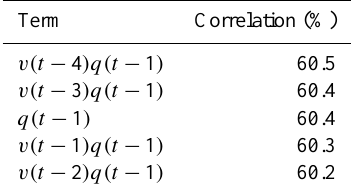
Table 2. Correlation test results for the example system. Table 3. Solar wind-Dst index coupling functions assembled by the ERR